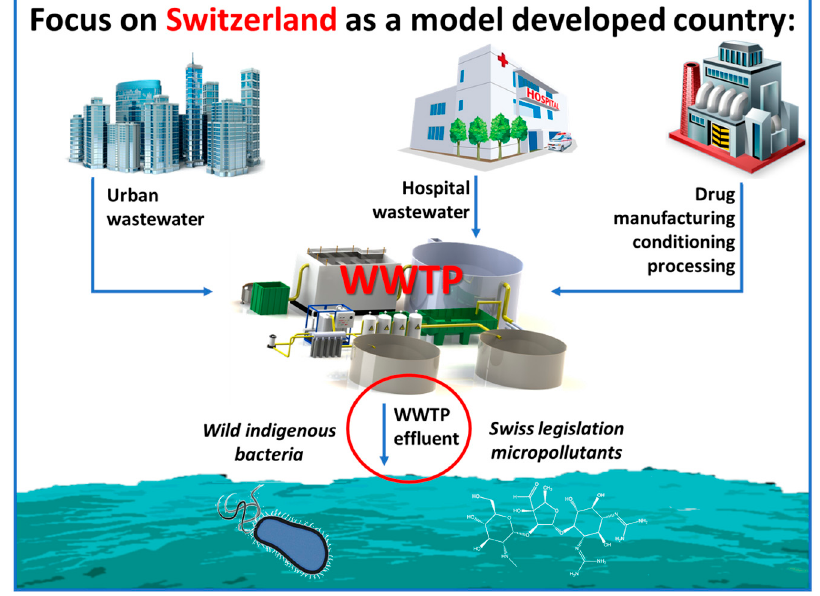
Figure 1. Schematic representation: Treatment focus, strategy and targets of WWTP by light- assisted AOPs in developing countries. Switzerland and its motion of upgrading the WWTPs is studied, presenting solutions based on the application of mainly UV-based AOPs, compared with the solar photo-Fenton. The targets are the micropollutants chosen by the Swiss evolution of control policy and the indigenous population of bacterial microorganisms present in